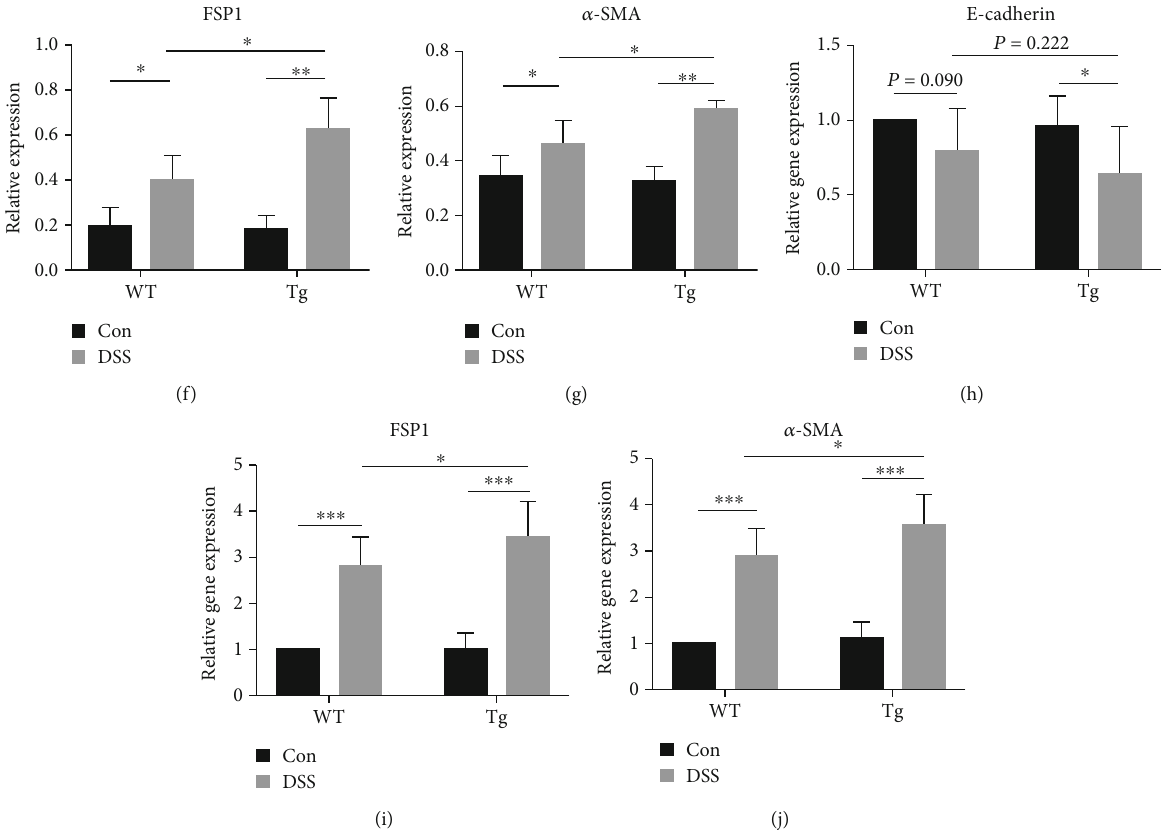
Figure 4: TL1A promotes EMT in the DSS-induced intestinal fi brosis model. (a) Immuno fl uorescence staining of colon tissue sections from wild type (WT) and transgenic (Tg) mice probed with antibodies against E-cadherin (green) and FSP1 (red) (400x). E-cadherin + FSP1 + cells (yellow; re fl ects EMT). Nuclei are stained with DAPI (blue). (b) Immunohistochemical staining of β -catenin in colon tissues of mice groups (400x). (c – g) Western blot analysis of total protein of β -catenin, E-cadherin, α -SMA, and FSP1 in intestinal tissue, normalized with GAPDH. (h – j) RT-PCR analysis of E-cadherin, α -SMA, and FSP1 mRNA levels in the indicated groups. Data were given as mean ± standard deviation (SD). As compared to the control group: ∗ P < 0 : 05 , ∗∗ P ≤ 0 : 01 , and ∗∗∗ P ≤ 0 : 001